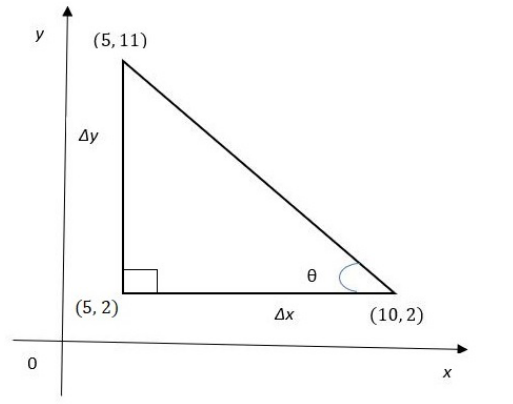
Figure 2. Construction of a right angled triangle using ∆ y .